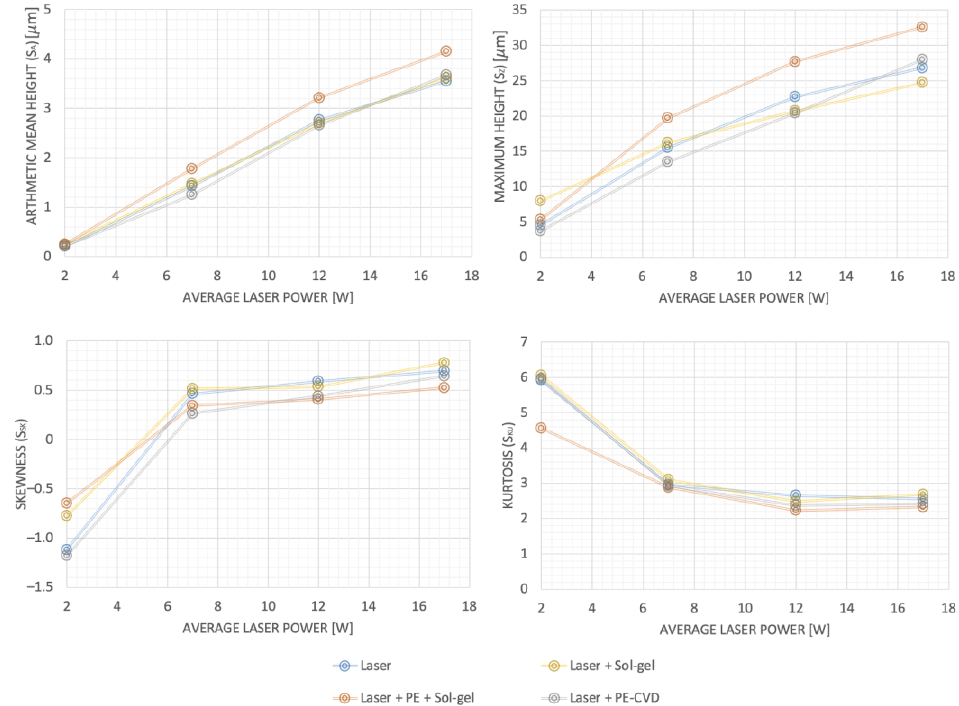
Figure 11. Comparison of arithmetic mean height, S a , maximum height, S z , skewness, S sk , and kurtosis, S ku , of laser-textured surfaces without coating and Surf 1 (laser texturing + sol–gel (TEOS)), Surf 3 (laser texturing + sol–gel (APTES + PE interlayer)), and Surf 4 (laser texturing + PE-CVD) samples obtained with parallel lines scanning strategy.